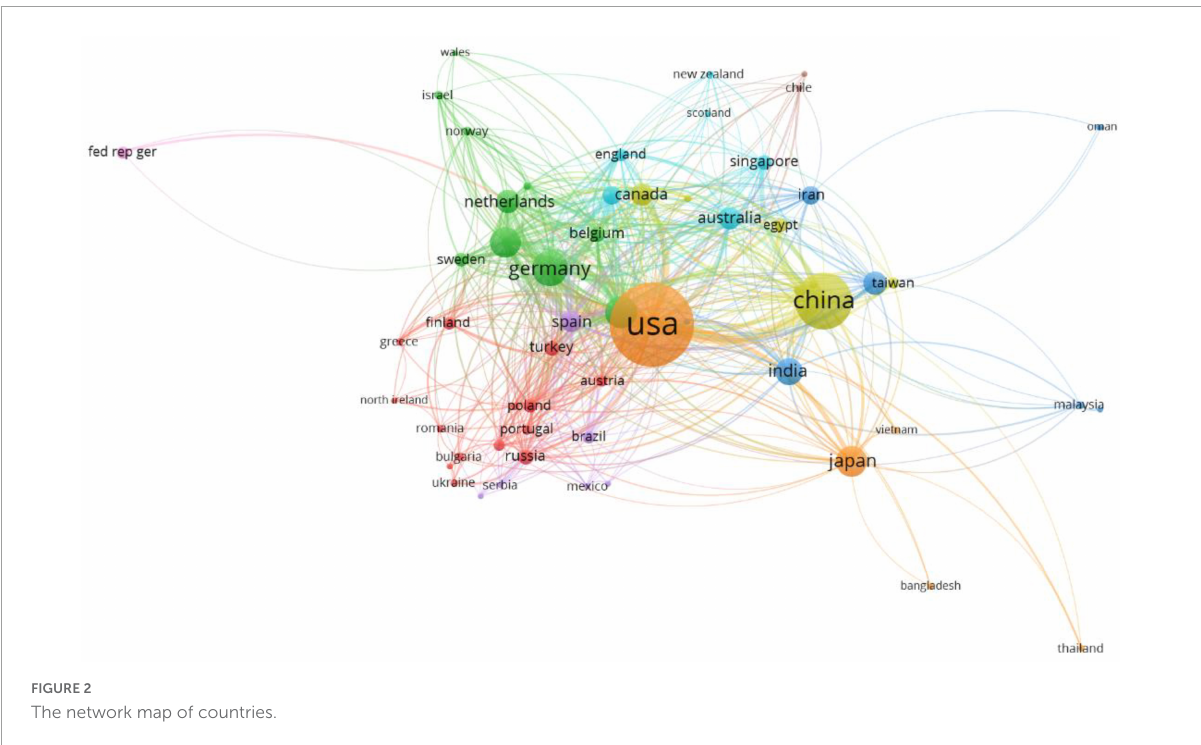
FIGURE2 The network map of countries.